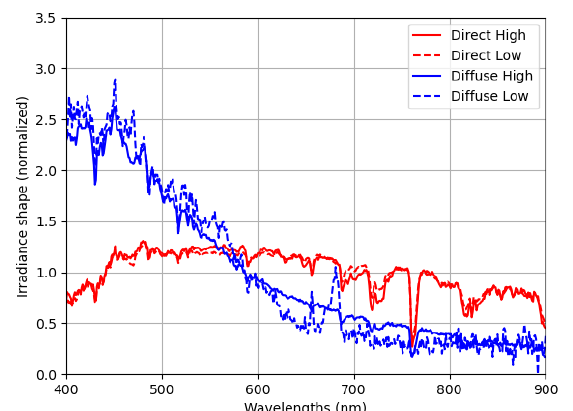
Figure 5 . Diffuse and direct irradiance spectrum endmembers extracted using the Köppl method at the full sunshine (“High”) and under shadow of a cloud (“Low”)